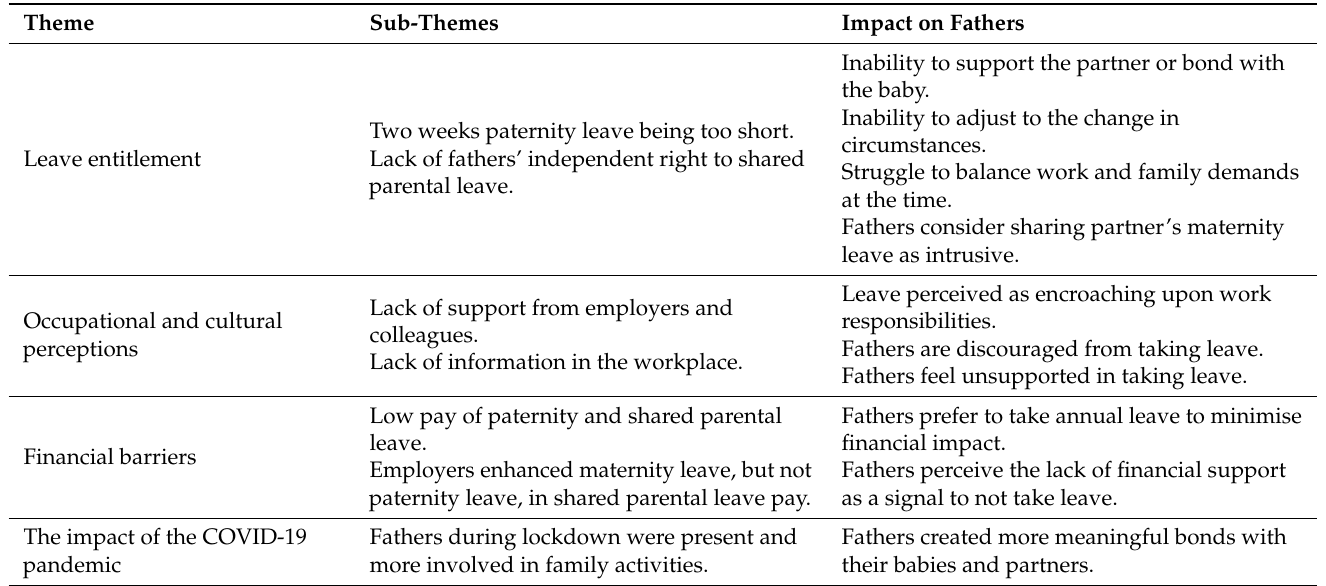
Table 1. Identified themes and